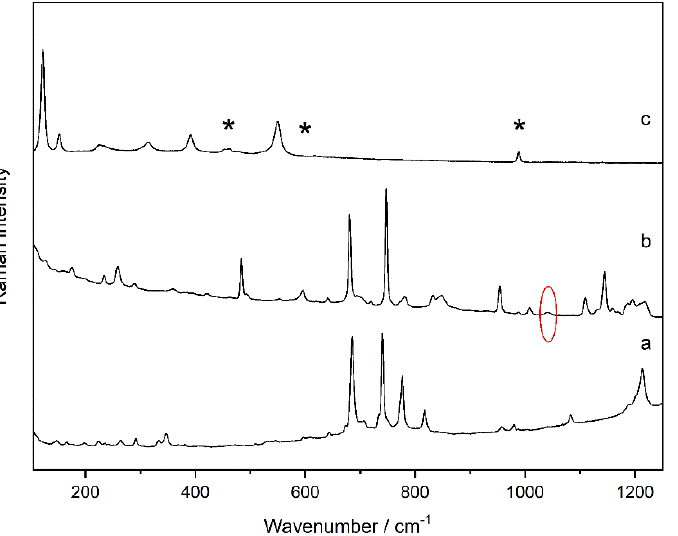
Figure 1. Raman spectra of the compounds identified in the subsample (SUBS-1a) in cross-section: phthalocyanine green ( a ), phthalocyanine blue with traces of azo pigment PY100 (in the red circle) ( b ), minium plus barium sulfate (*) ( c ).